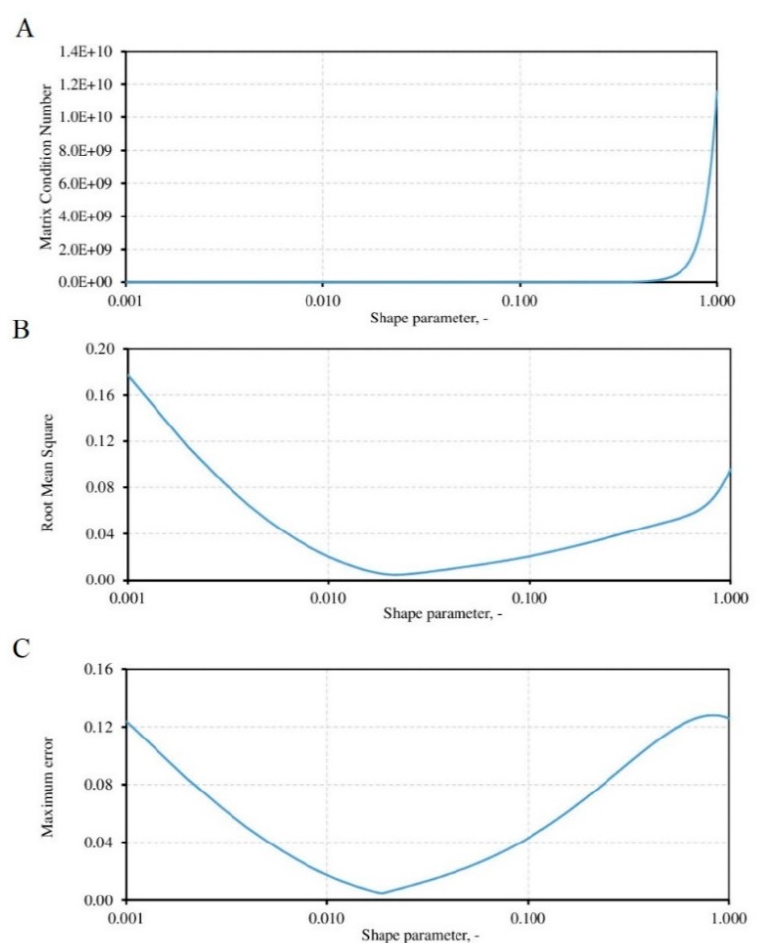
Figure 9. Shape parameter influence on: ( A ) matrix conditioning number, ( B ) root mean square (RMS) error, ( C ) maximum error.